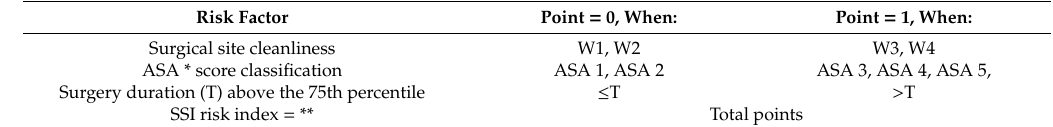
Table 1. Studied risk factors of